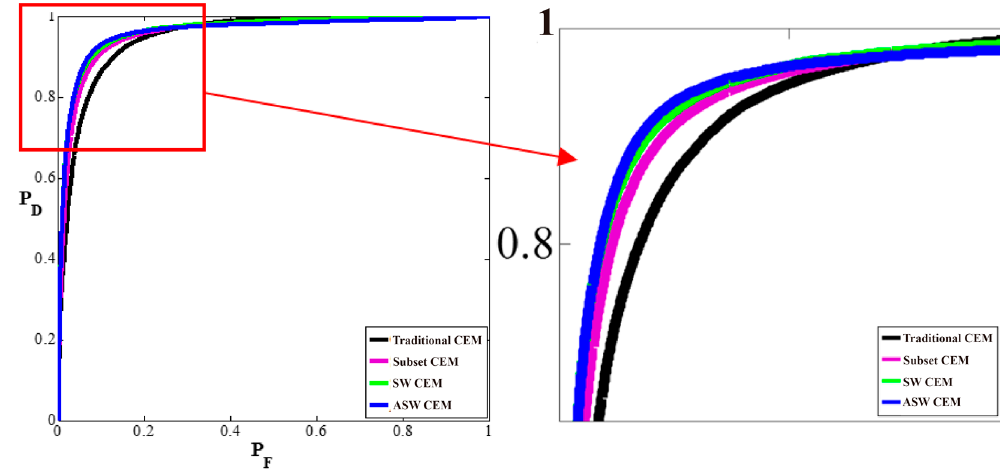
Figure 19. ROC curves of local and global CEMs on Region 2. Table 4. Detection results of traditional CEM and our proposed CEMs in the image of Region 1. Detection